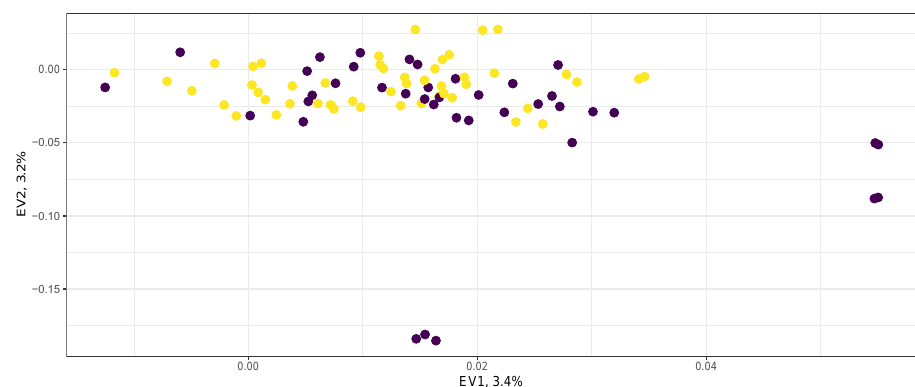
Figure 2. Cont B